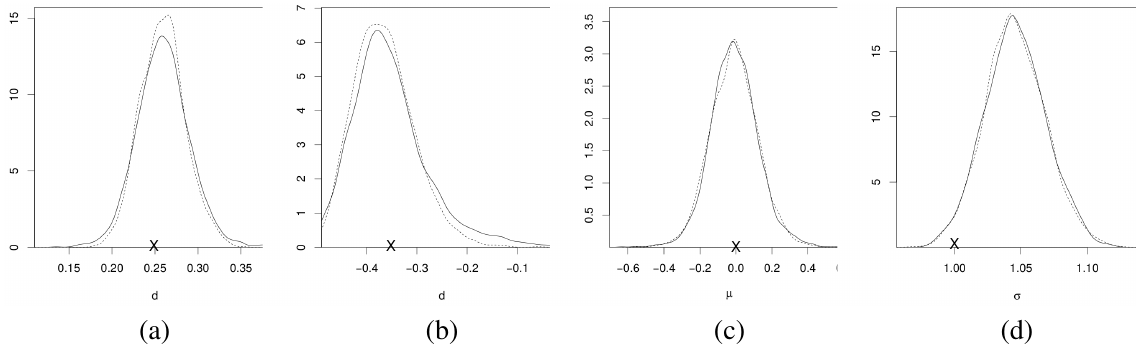
Figure 8. Marginal posterior density of d from series in Fig. 6, (a, b) . Solid line is density obtained using reversible-jump algorithm. Dotted line is density obtained using fixed p = 1 and q = 0. The true values are d l = 0.25 and − 0.35, respectively. (c, d) Shows the posterior densities for µ and σ , respectively, corresponding to the series in Fig. 6a; those for Fig. 6b look similar. The true values are µ = 0 and σ = 1. True values are marked by an X.